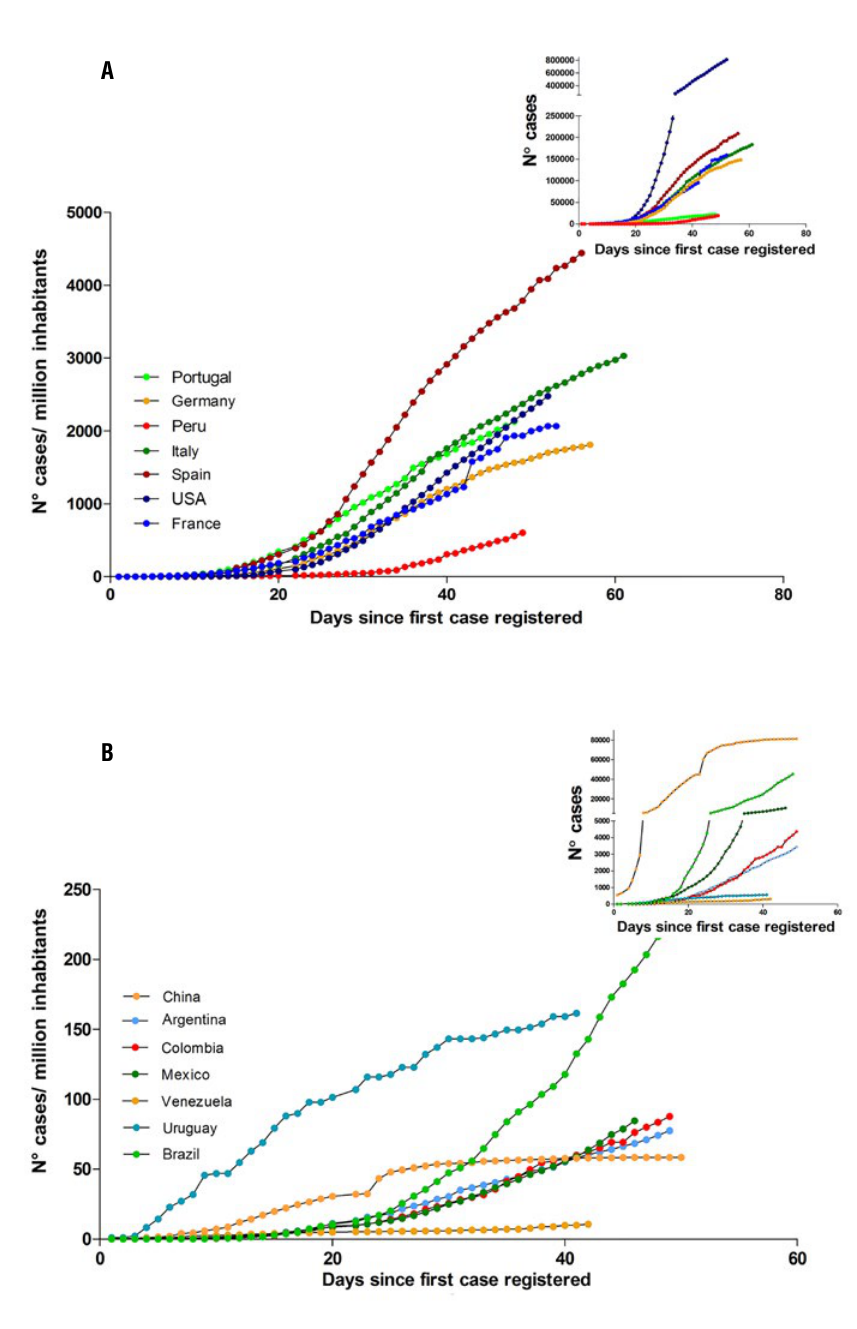
Figure 3 - SARS-CoV-2